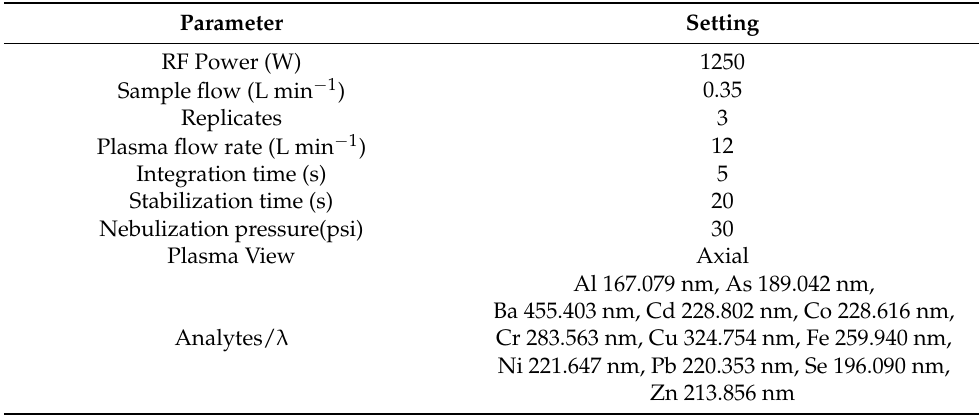
Table 2. ICP-OES instrumental